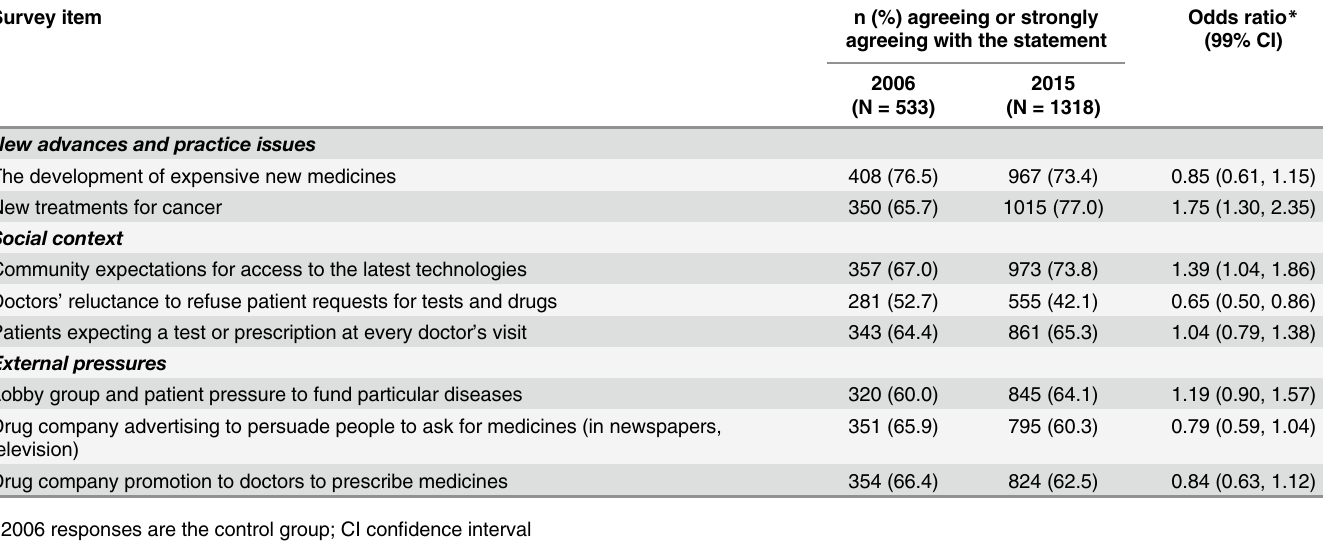
Table 2. Contributors to rising health care